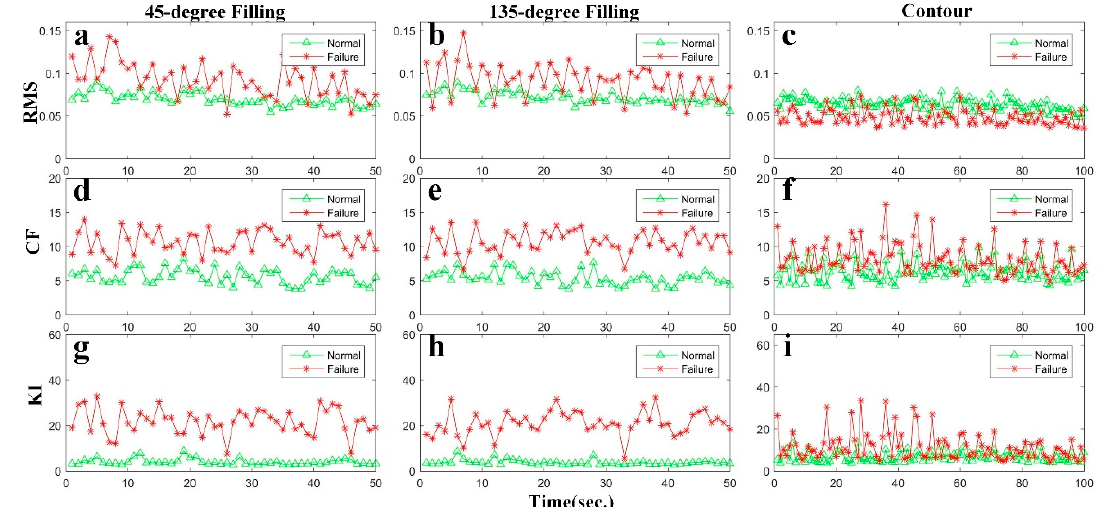
Figure 6. The values of (RMS), crest factor (CF), and Kurtosis index (KI) for training data. The red lines represent the filament jam state, the green lines represent the normal state: ( a )–( c ): the RMS values; ( d )–( f ) the CF values; ( g )–( i ) the KI values.